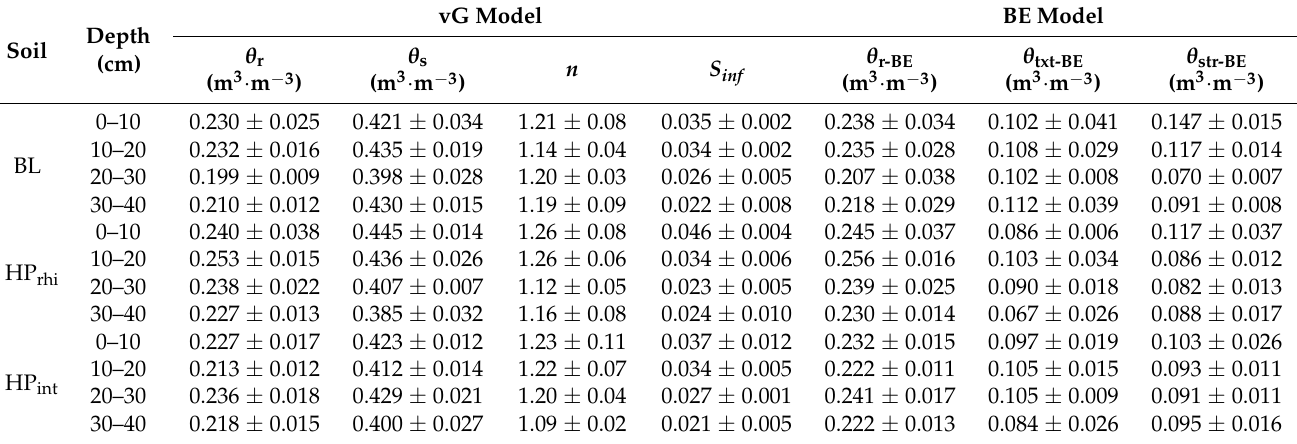
Analysis of characteristics of 3 pore size classes (i.e., r > 125 µm, 0.1 < r < 125 µm and